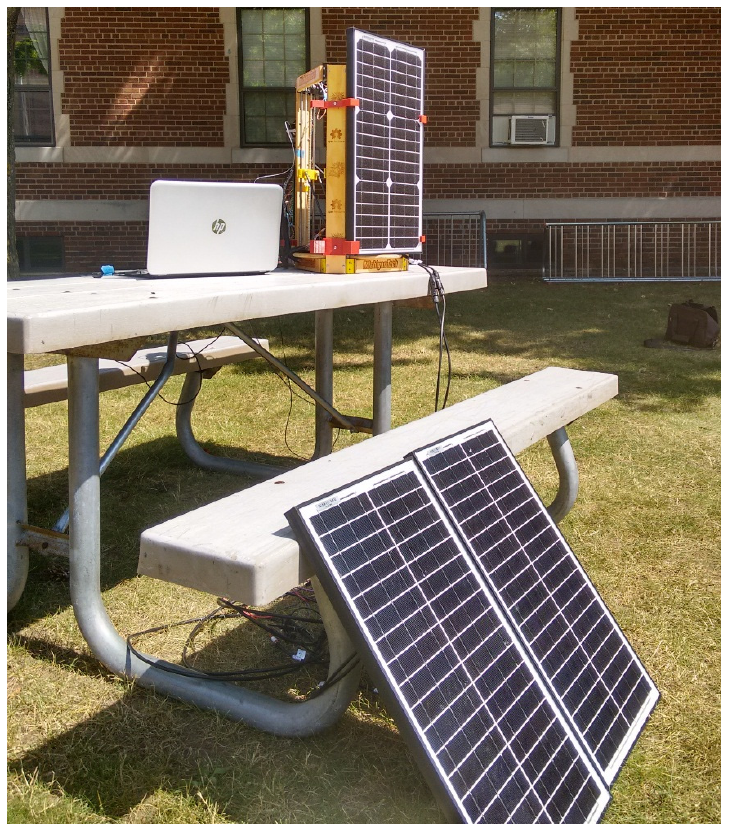
Figure 9. Photograph of the MOST-delta 3D printer and PV stand-alone power system assembly with PV deployed.